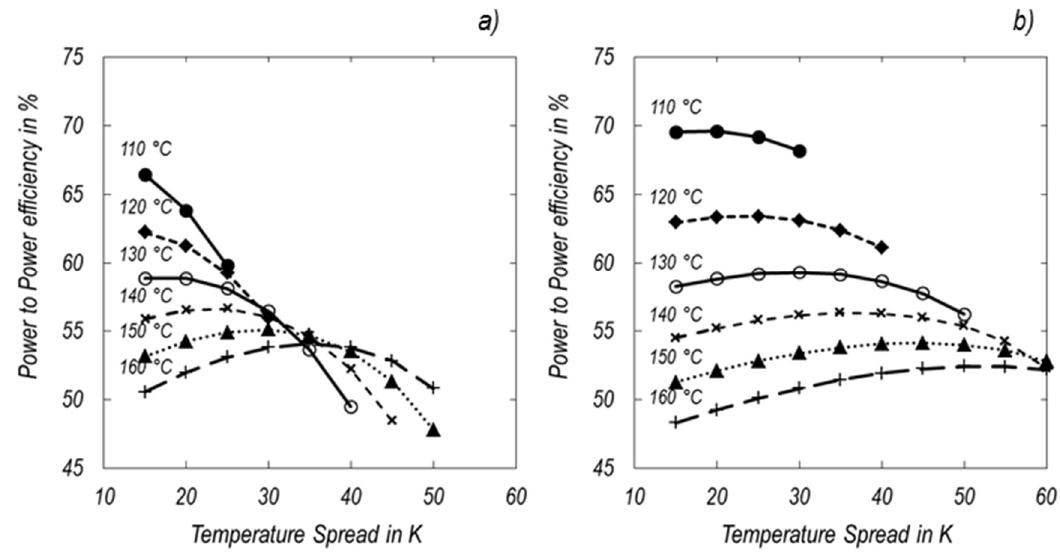
Figure 10. Impact of storage temperature levels on the power-to-power efficiency (( a ) single stage process; ( b ) two stage process).